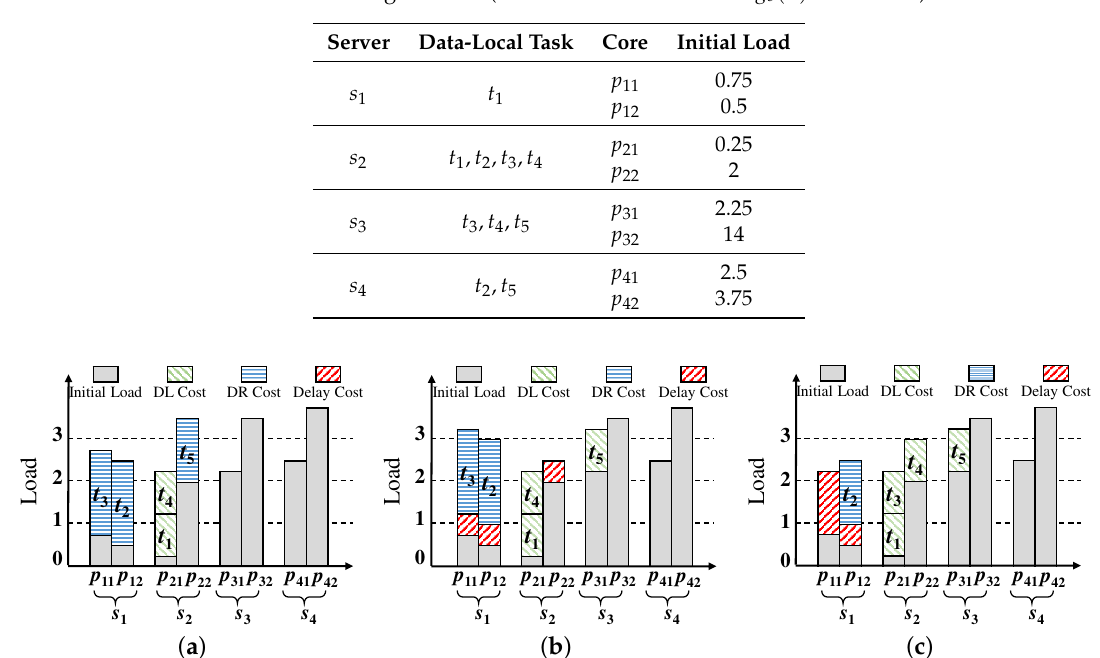
Table 2. A scheduling instance (data-remote cost function g s ( n ) = 1 + 0.5 n ).